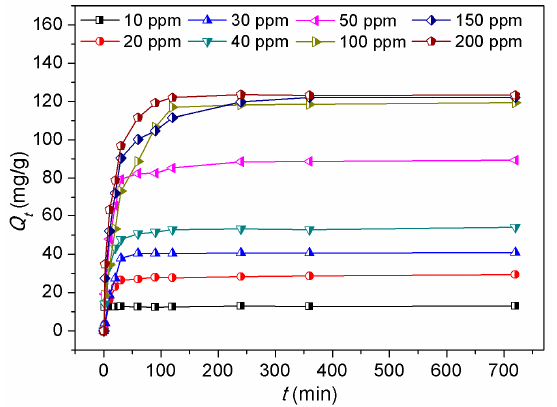
Figure 4. Time-dependence of adsorption profiles of MyB over adsorbent 1 at varying initial dye concentrations at room temperature.